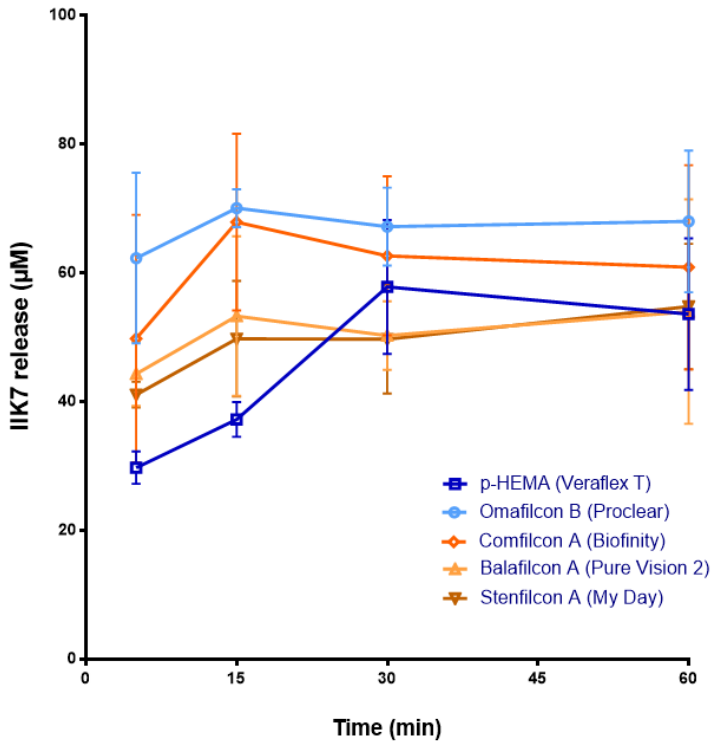
Figure 1. The IIK7 release from CLs previously soaked with IIK7 solution (1 mL, 1 mM) for 12 h to a saline solution (1 mL) over 60 min. Concentration ( µ M) values are presented as mean ± S.D of n = 9 lenses per material. The blue color shows the release from CH CLs. The ochre color shows the release from SH CLs.